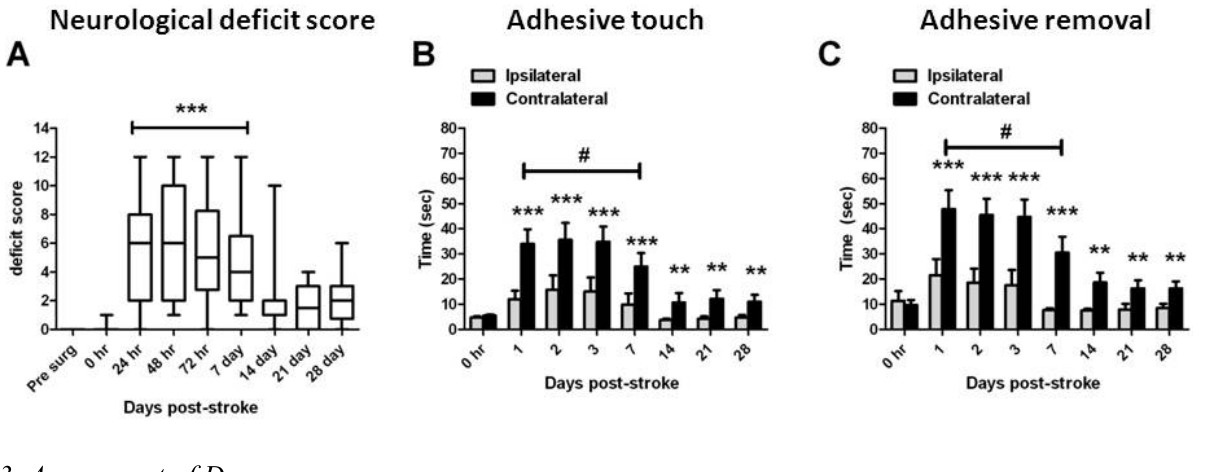
Figure 1. Long term neurological outcomes following ET-1 induced stroke. Combined neurological deficit scores ( A ) from all rats assessed in this study up to 28 days. Data presented as box plots include hinges extending from the 25th to 75th percentiles, the median line within the box and whiskers extending to the minimum and maximum values of the dataset. *** p < 0.001 compared with pre-stroke scores (non-parametric ANOVA). Latency to touch ( B ) and remove ( C ) a sticky label on the contralateral (stroke affected) forelimb compared with the ipsilateral forelimb from all rats assessed up to 28 days after stroke. Data presented as mean ± S.E.M. of time taken to touch each stimulus and then remove the stimulus. ** p < 0.01; *** p < 0.001 compared with the ipsilateral forelimb at the same time measurement (RM ANOVA); # p < 0.05 compared with the ipsilateral forepaw at 0 h (RM ANOVA). n = 35 assessed 1–3 days; n = 26 assessed day 7; n = 16 assessed day 14; n = 8 assessed days 21 and 28 for all behavior